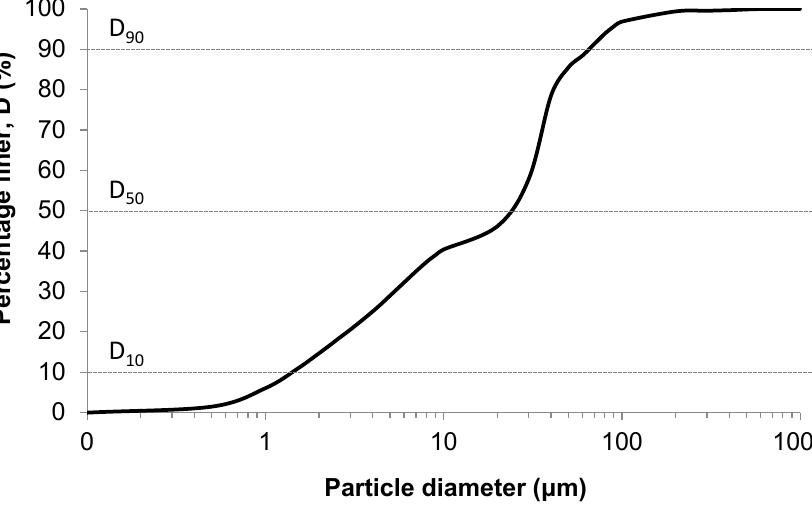
Figure A3. XRD pattern of GGBFS (m: merwinite PDF 35-0591, a: akermanite PDF 01-087-0046, b: brownmillerite PDF 01-074-3673 and q: quartz PDF 33-1161).